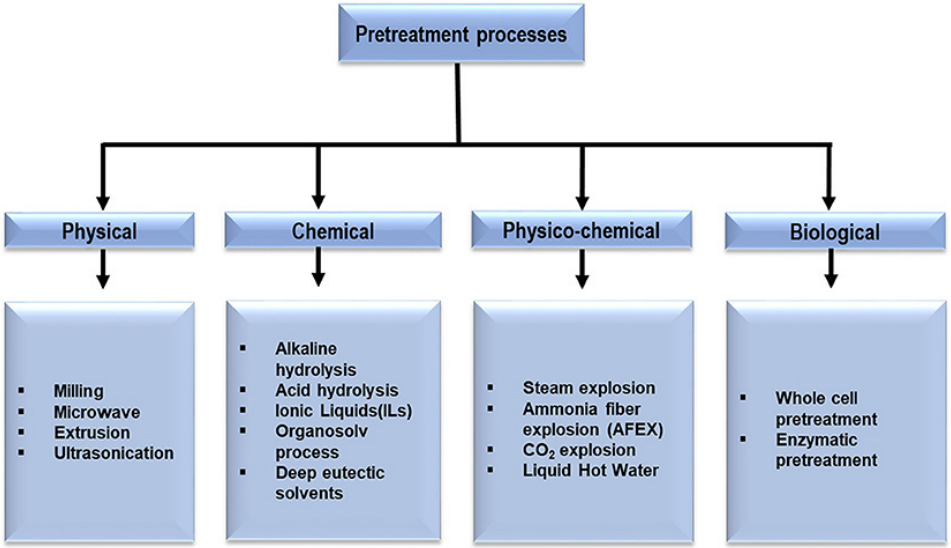
Figure 2. Flow chart diagram of pretreatment processes. Reprinted with permission from Baruah et al. Recent Trends in the Pretreatment of Lignocellulosic Biomass for Value-Added Products. Frontiers in Energy Research . Copyright (2018) Frontiers [28].